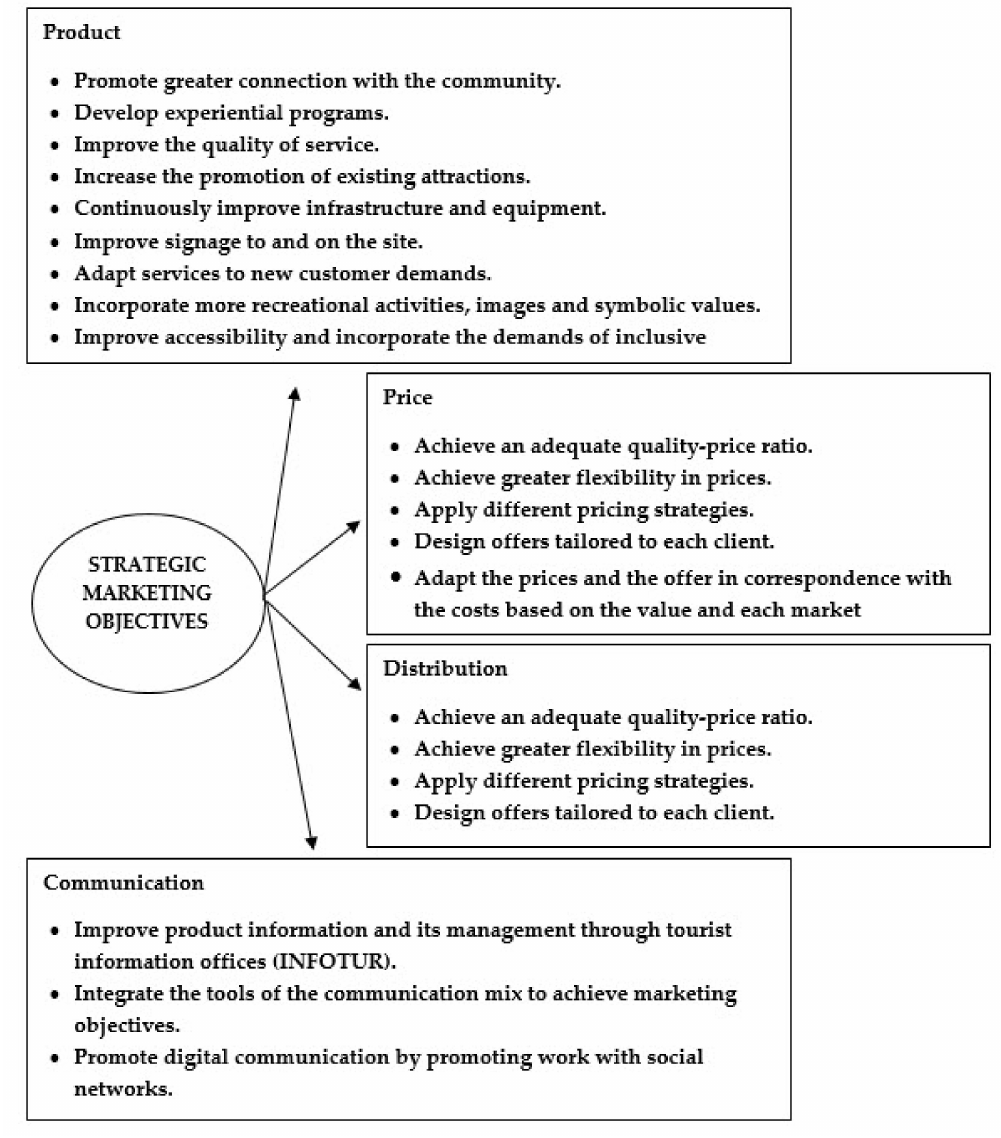
Figure 10. Strategic objectives for each marketing variable Source: own elaboration from the market- ing